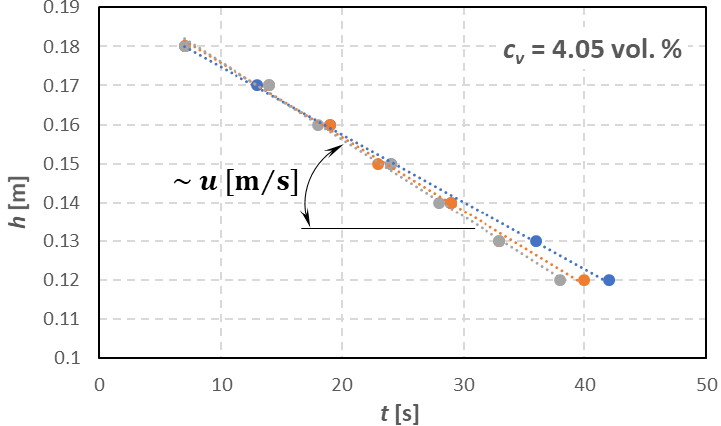
Figure 3. Illustration of the primary measured data and evaluation of the settling velocity of the particle cloud.